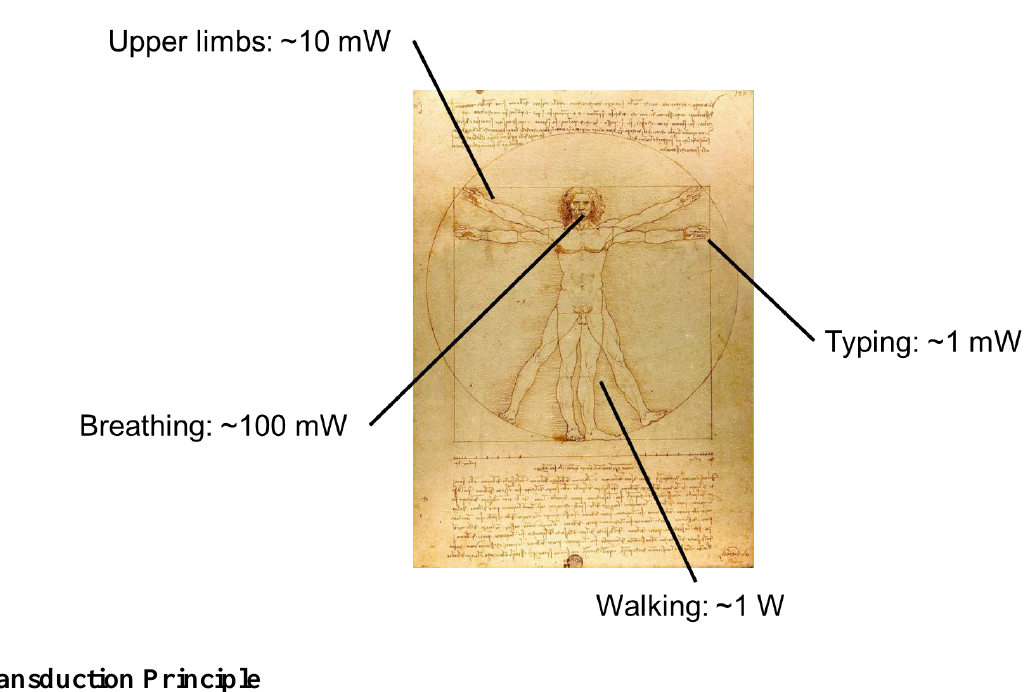
Figure 2. Estimation of available power that could be harvested during human activities (Adapted from